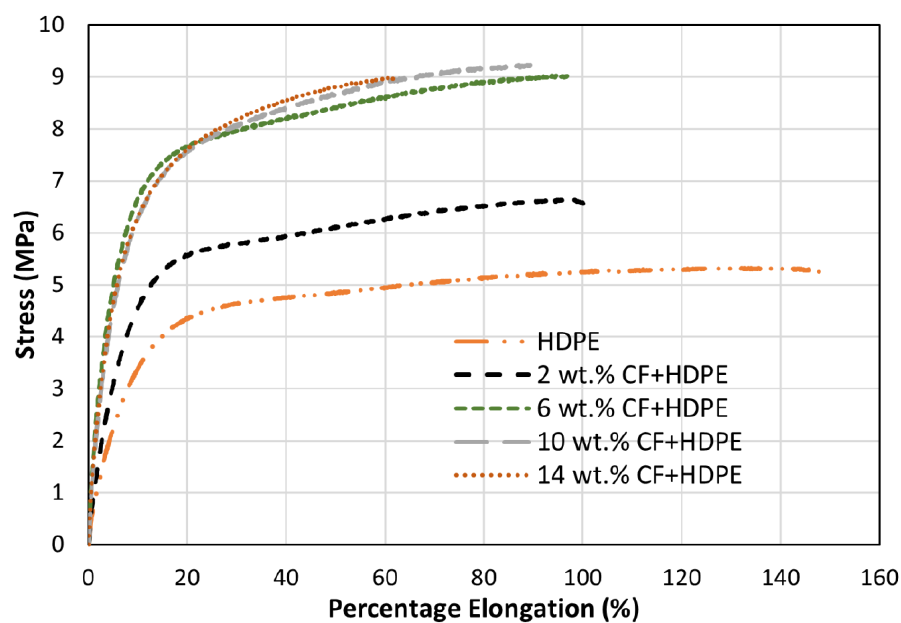
Figure 6. Effects of CFs on tensile properties.